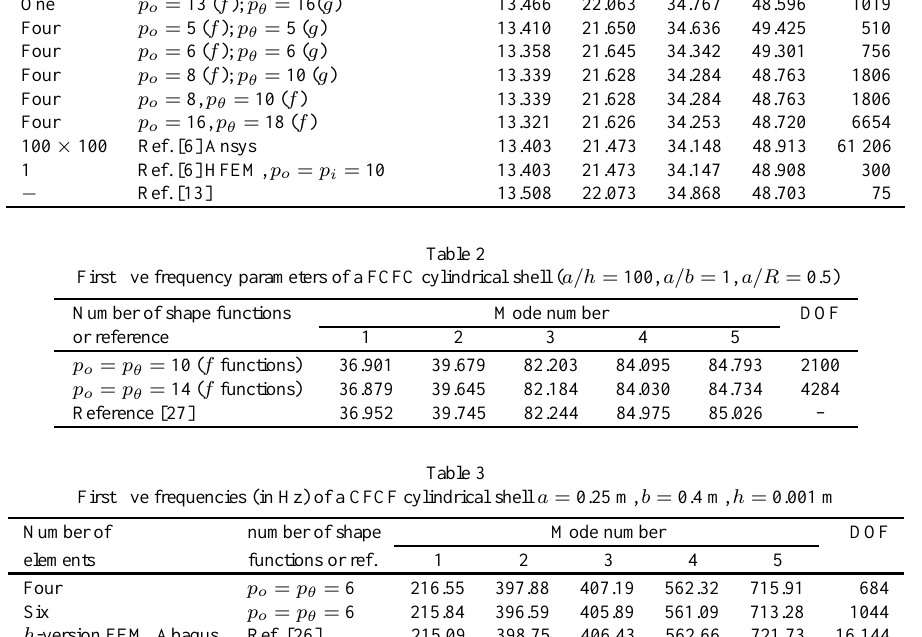
Table 1 First four frequency parameters of a completely free cylindrical shell ( a/h = 100, a/b = 1, a/R = 0.5) Number of Number of shape functions ( p -version) Mode number DOF elements